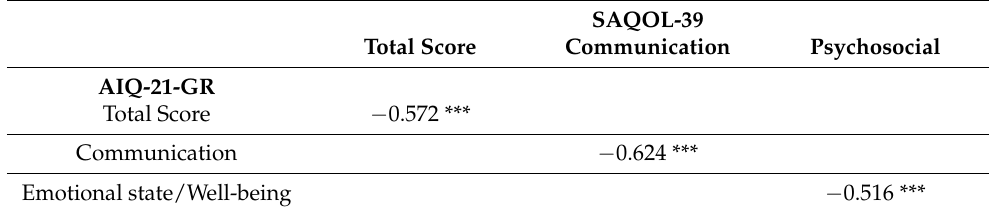
Table 5. Spearman rho correlations between AIQ-2-GR and SAQOL-39.